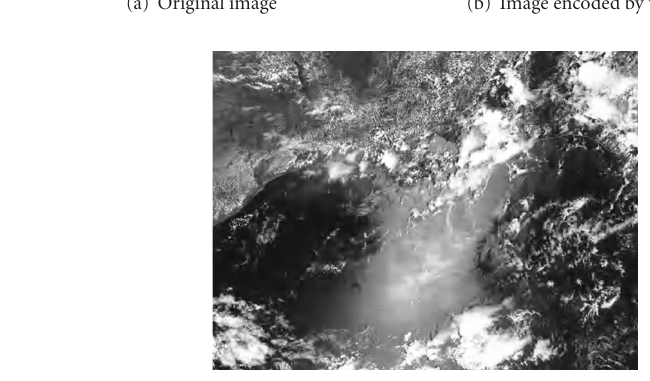
points is narrowed during Tier-2 encoding. The simulation results show that the proposed algorithm can improve the code e ffi ciency and greatly reduce the bu ff er size. At the same time, the peak signal-to-noise ratio of coded images remains almost the